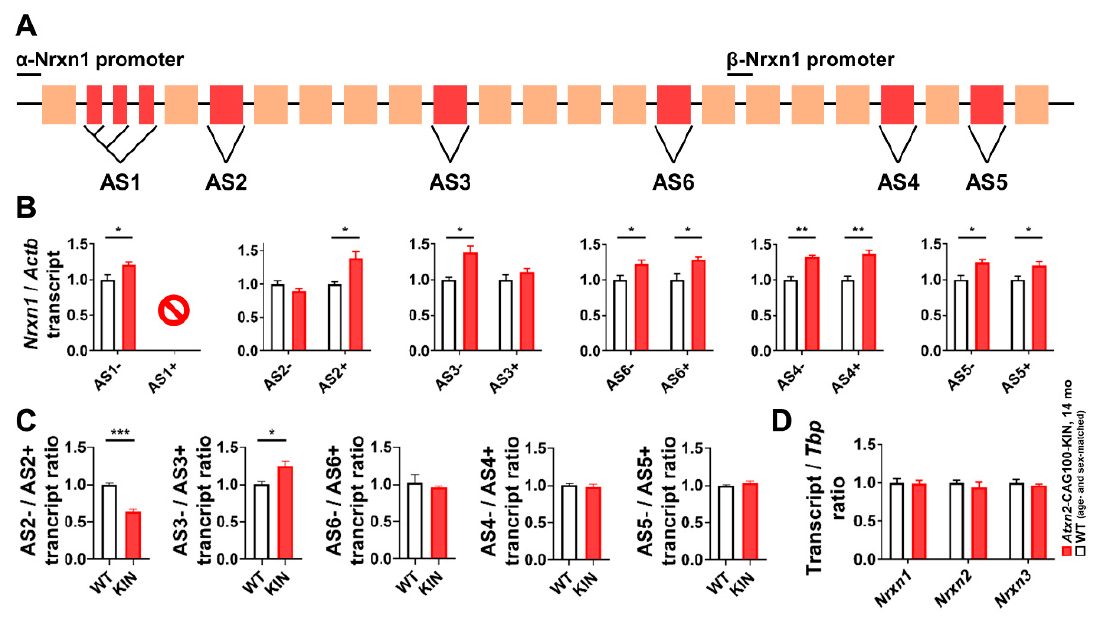
Figure 5. Expression analyses of Nrxn1-3 transcripts and alternative splicing isoforms of Nrxn1 in Atxn2 -CAG100-KIN cerebellum at 14 mo. ( A ) Schematic representation of Nrxn1 structure showing six alternative splice (AS) sites. Constitutive exons are depicted in beige and alternatively spliced exons are in red. The transcript structure and spatial distribution of the AS sites were adapted from Treutlein et al. 2014 [70]; ( B ) Transcript levels of spliced ( − ) or unspliced ( + ) variants of Nrxn1 at AS1-6 show altered splicing in Atxn2 -CAG100-KIN cerebellum at 14 mo. Site-specific primers were designed to selectively amplify exon inclusion or excision at a given AS site by RT-qPCR. At AS1 site, only AS1( − ) isoform lacking all intermediate exons could be quantified with this method, due to the structural complexity of the region and impossibility of proper primer design for all splice variants; ( C ) Splicing activity ratio at AS2-6 sites of Nrxn1 reveal the missplicing of AS2 and AS3 sites in Atxn2 -CAG100-KIN cerebellum at 14 mo. The ratio between spliced ( − ) to unspliced ( + ) variants shown in panel B was calculated for each AS site to assess splicing activity at each site. Significantly decreased activity at AS2, and significantly increased splicing at AS3 was observed; ( D ) Total levels of Nrxn1-3 transcripts measured by RT-qPCR amplifying constitutive exons showed no dysregulation in Atxn2 -CAG100-KIN cerebellum at the terminal disease stage. Student’s t -test with Welch’s correction; p < 0.05 *, p < 0.01 **, p < 0.001 ***. Further information regarding individual fold changes and p -values can be found in Supplementary Table S3.